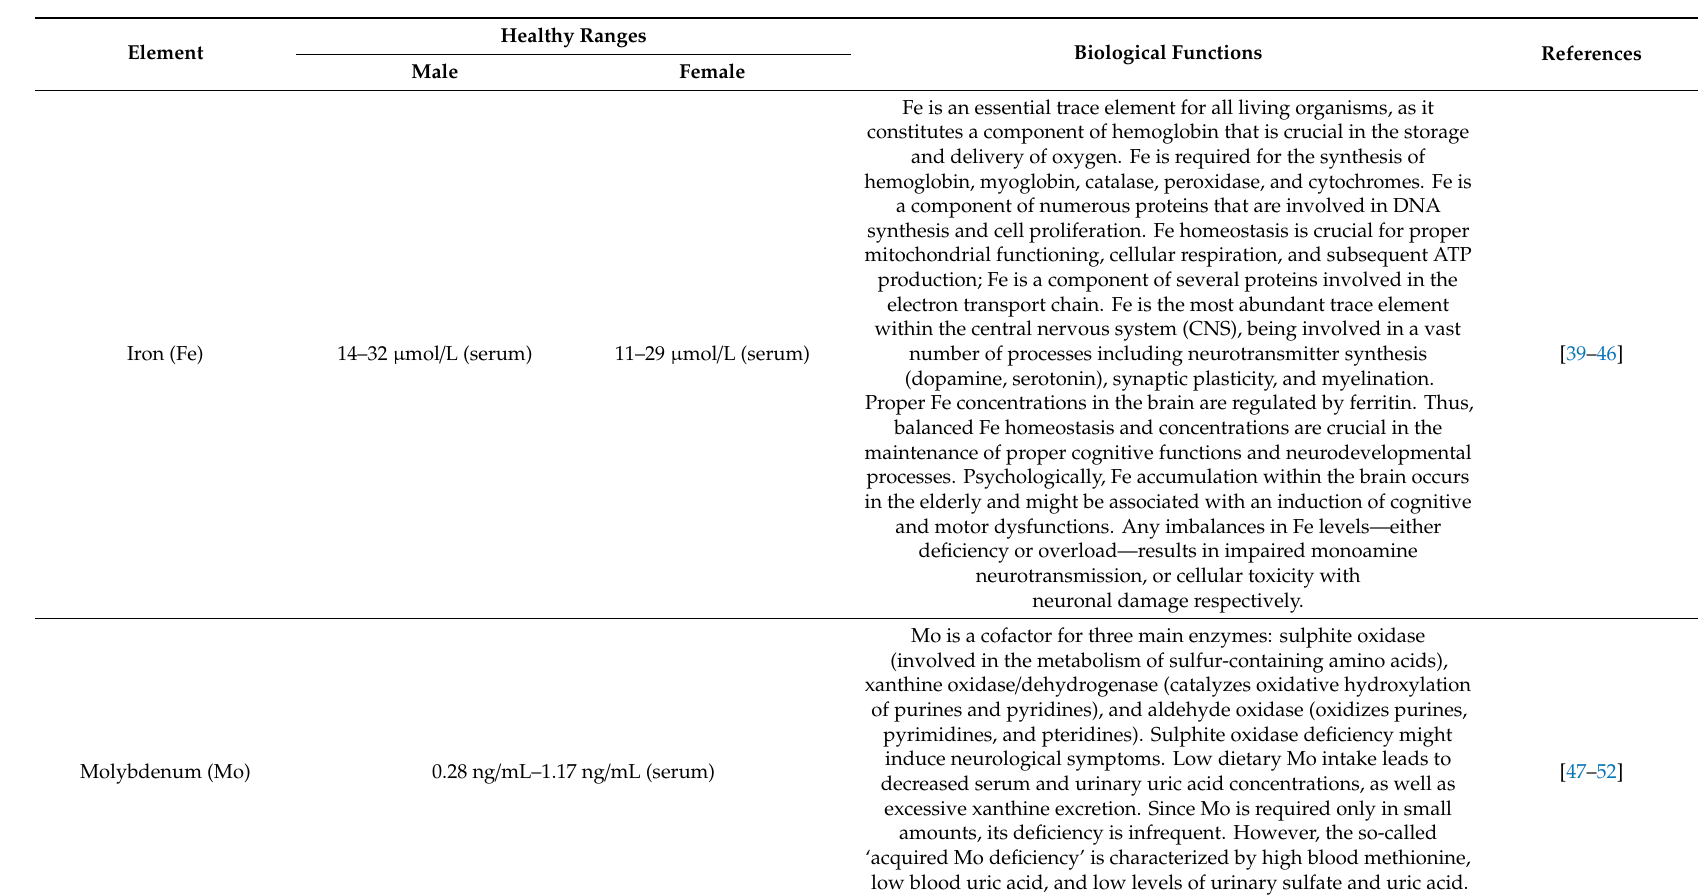
Table 1. Physiological ranges and biological functions of trace elements in the human